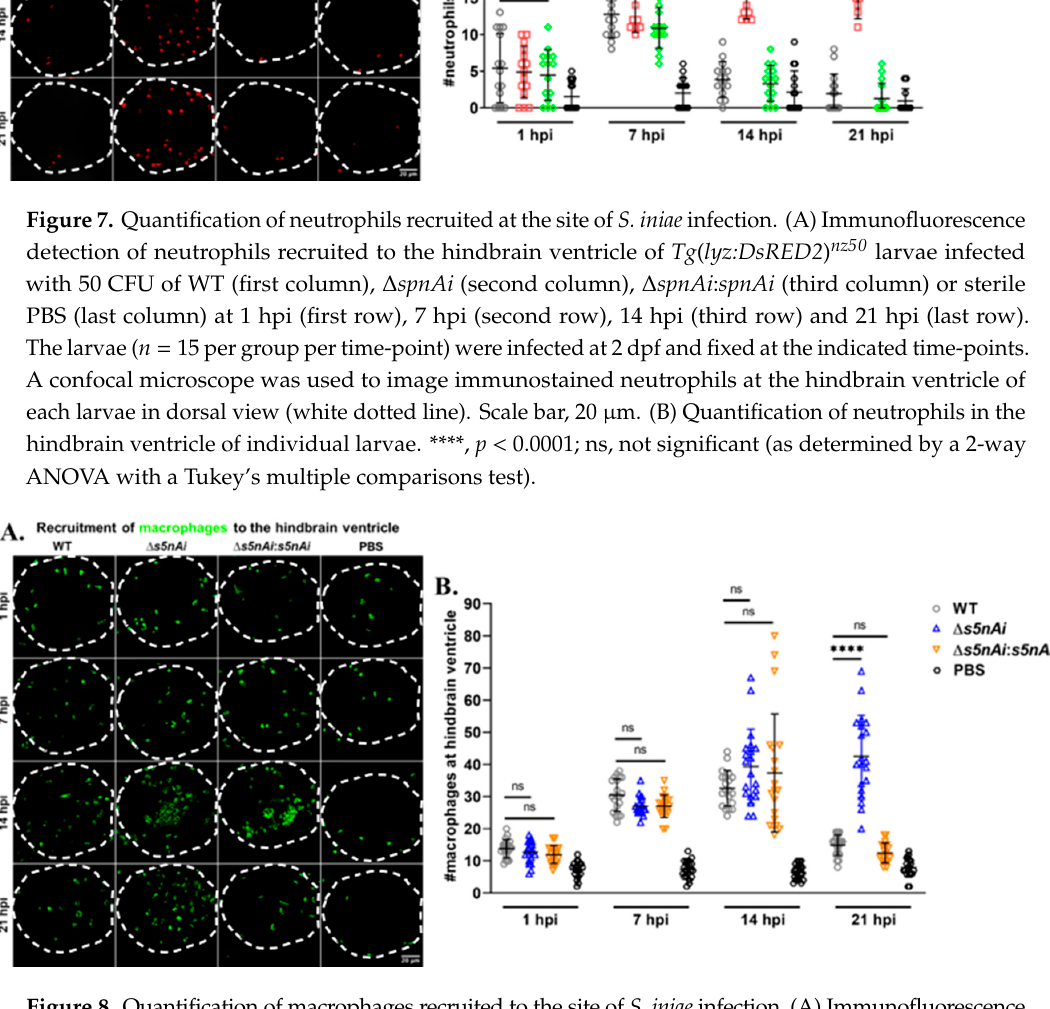
Figure 8. Quantification of macrophages recruited to the site of S. iniae infection. (A) Immunofluorescence detection of macrophage recruited to the hindbrain ventricle of Tg ( mpeg1:EGFP ) gl22 larvae infected with 50 CFU of WT (first column), Δ s5nAi (second column), ∆ s5nAi : s5nAi (third column) or sterile PBS (last column) at 1 hpi (first row), 7 hpi (second row), 14 hpi (third row) and 21 hpi (last row). The larvae ( n = 20 per group per time-point) were infected at 2 dpf and fixed at indicated time-points. Confocal microscopy was used to image immunostained macrophages at the hindbrain ventricle of each larvae in the dorsal view (white dotted line). Scale bar, 20 µ m. (B) Quantification of macrophages in the hindbrain ventricle of individual larvae. An increase in the number of macrophages recruited to the hindbrain ventricle of infected larvae was seen compared to larvae injected with sterile PBS. The number of macrophages at the infection site for all infected larvae peaked at 14 hpi. At 21 hpi, the number of macrophages recruited to the infection site of larvae infected with WT and ∆ s5nAi : s5nAi was significantly lower as compared to Δ s5nAi . ****, p < 0.0001; ns, not significant (as determined by a 2-way ANOVA with a Tukey’s multiple comparisons test).